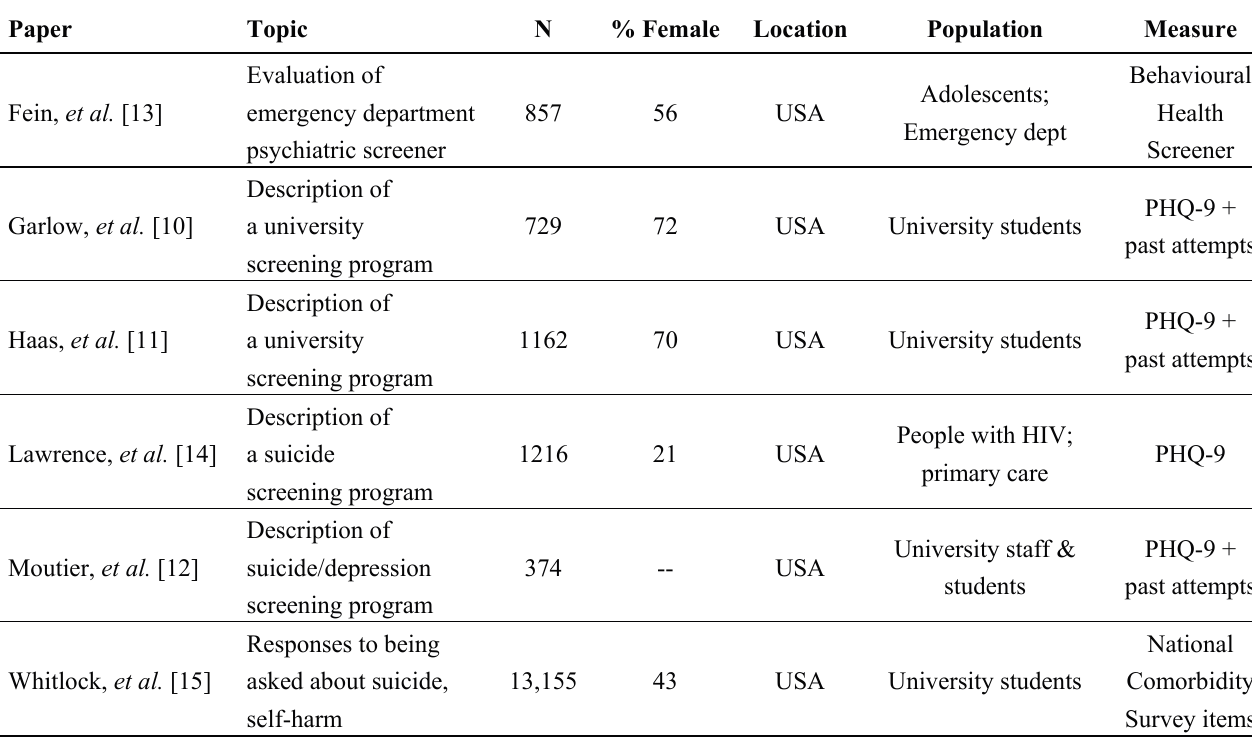
Table 1. Studies of online screening for suicidal thoughts or behaviours identified in the